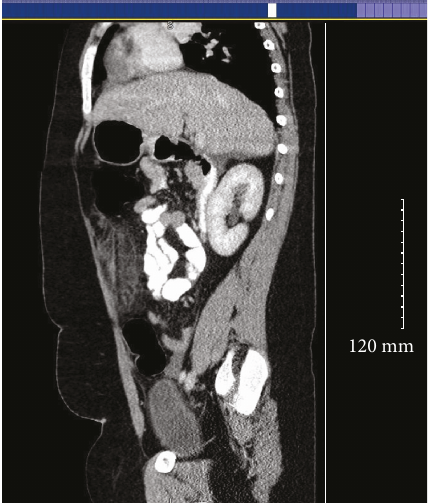
Figure 2: Sagittal CT indicating omental in fl ammation and fat stranding.